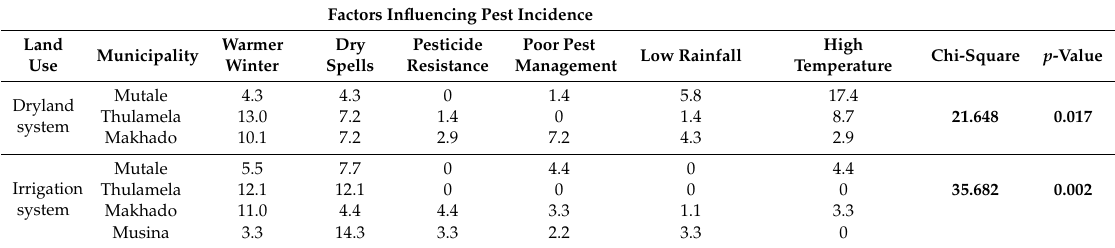
Table 6. Factors influencing insect pest incidence mentioned by smallholder farmers across